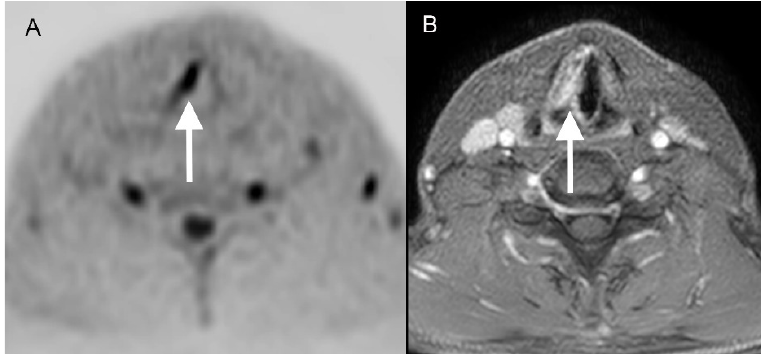
Figure 4. A fifty-year-old patient with a pT1a cN0 cM0 squamous cell carcinoma of the right vocal cord which was detectable for both readers in DWIBS (( A ); white arrow) as well as in contrast-en- hanced transversal T1-weighted scans with fat saturation (( B ); white arrow).